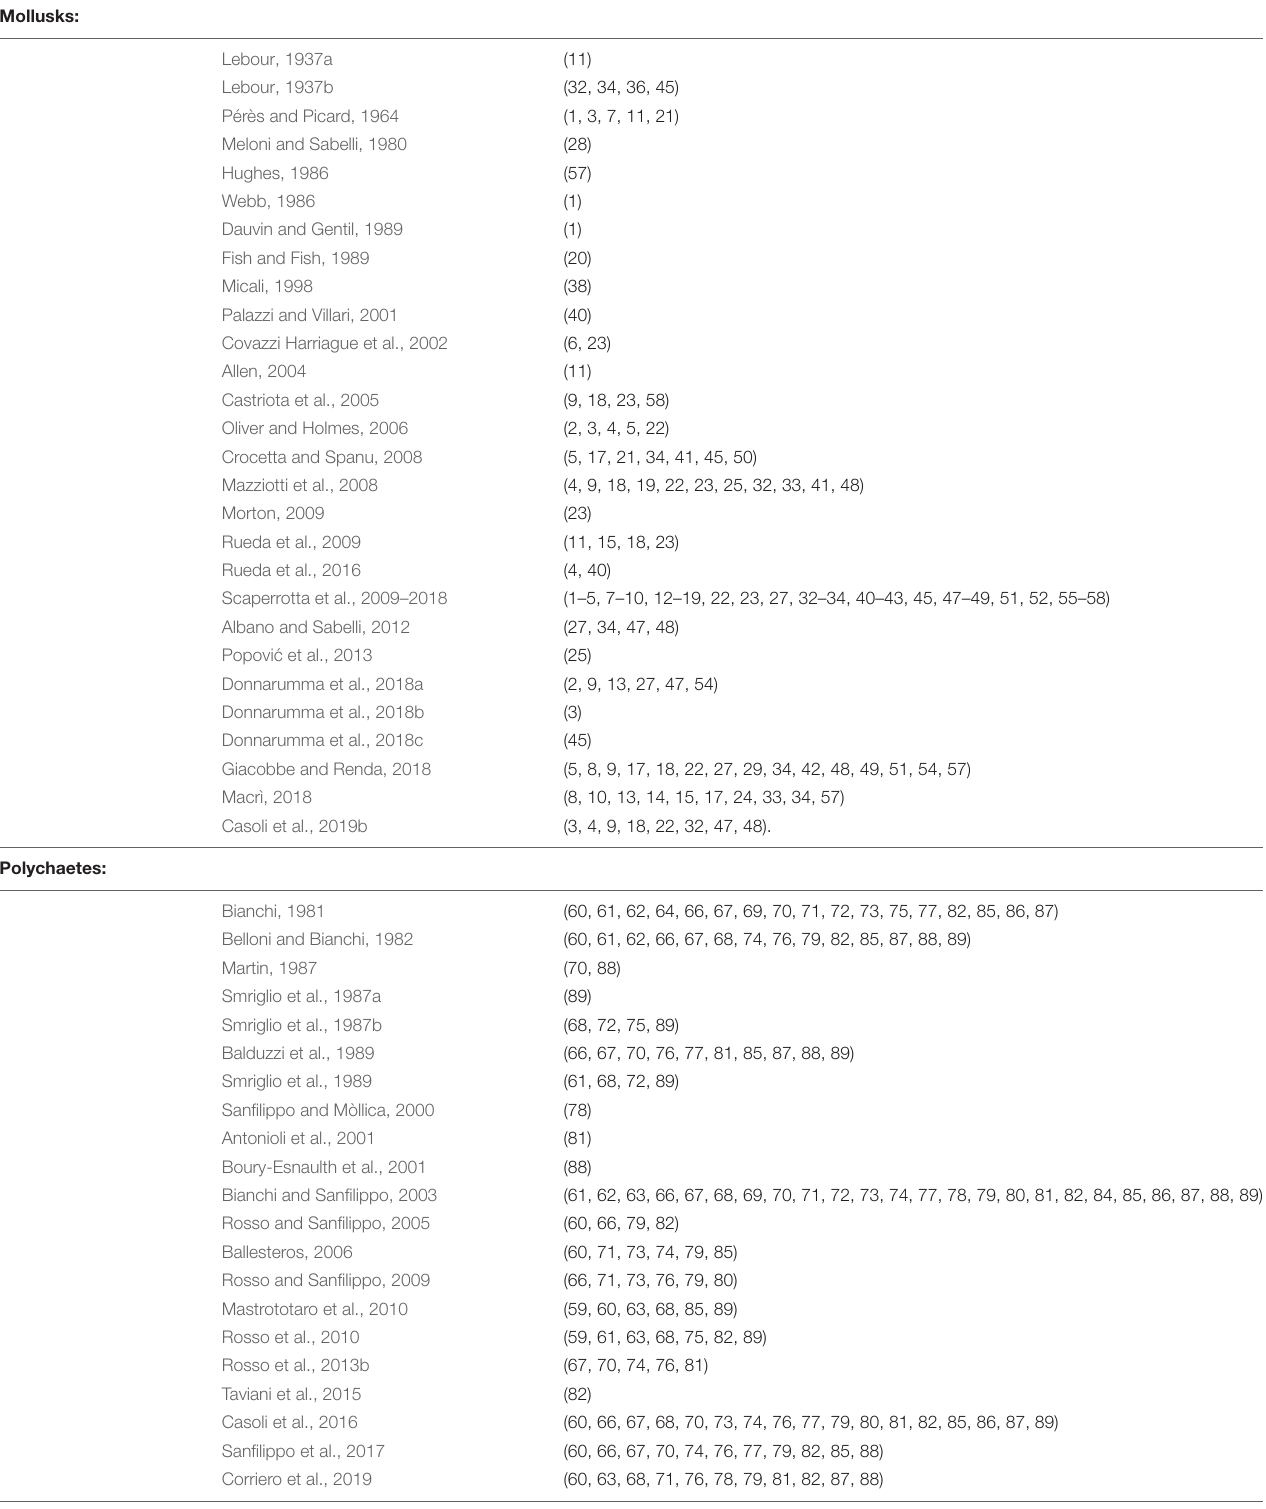
TABLE 2 | List of the references providing information on the functional traits and ecological affinities of each species of mollusks, polychaetes, and bryozoans found in the ram; species are marked in brackets with the same numbers as Table 1 .